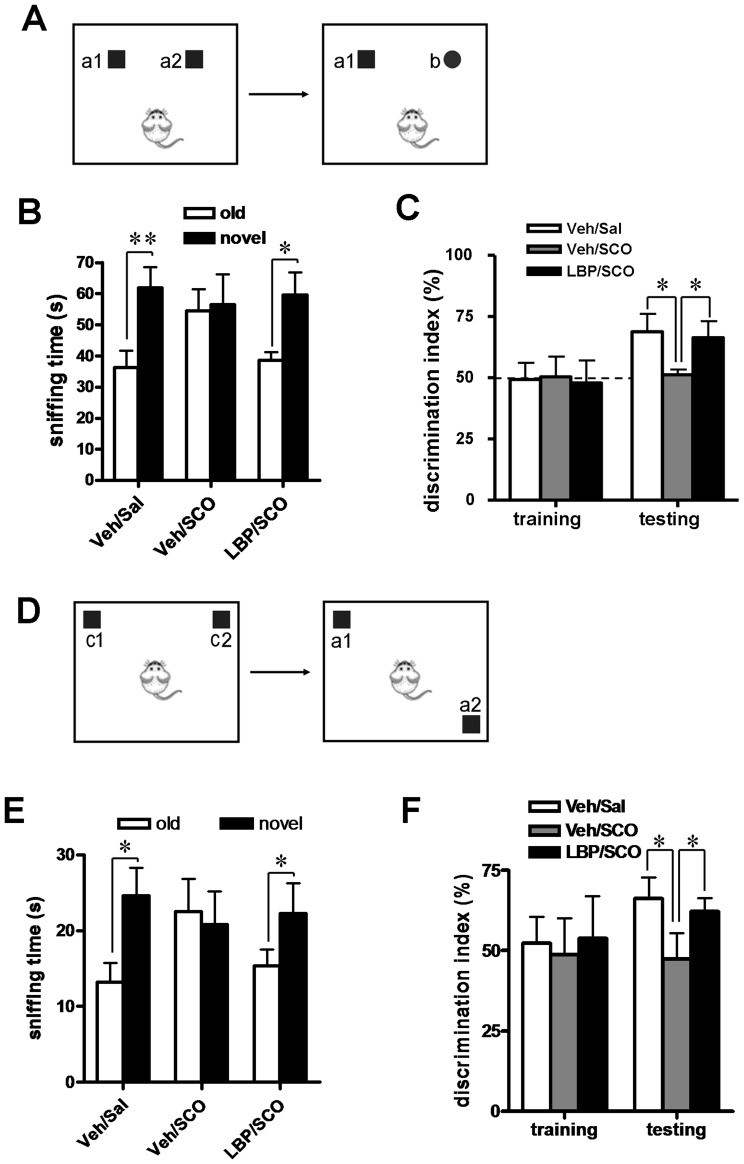
LBPs protect against SCO-induced impairments of working memory.(A) Diagram of the novel object recognition (NOR) task. Left (training phase), animals are exposed to two identical objects (a1 and a2). Right (test phase), animal are exposed to two different objects, a familiar (a1) object from the training phase and a new object (b) not seen before. (B) The total exploration time in two phases was recorded. Control (vehicle/saline) rats spent more time on exploring the novel object whereas vehicle/SCO animals explored the novel and familiar objects equally. LBP treatment (LBP/SCO group) restored the preference for the novel objects. (C) Discrimination indices in the test phase were calculated as the percentage of time spent exploring the novel object over the total time spent exploring both objects. The dashed line indicates the 50% (chance) level. (D) The object location recognition (OLR) task. Left (training phase), animals are exposed to two identical objects (c1 and c2). Right (test phase), animals are exposed to two same objects. One object (c1) is at the same location, but the other (c2) is relocated versus the training phase. (E) The total time exploring the objects in familiar and novel locations was recorded. Control rats spent more time exploring the relocated object whereas rats treated with SCO (vehicle/SCO group) showed no preference for the object at the new location. LBP treatment (LPB/SCO group) restored the preference for the novel location. (F) Discrimination indices in the test phase were calculated as the percentage of time spent exploring the new location over the total time spent exploring both locations. The dashed line indicates the 50% chance level. Values are means ± SEM (Vehicle/saline, n = 12; vehicle/SCO, n = 10; LBP/SCO, n = 11); *,P<0.05; **,P<0.01.